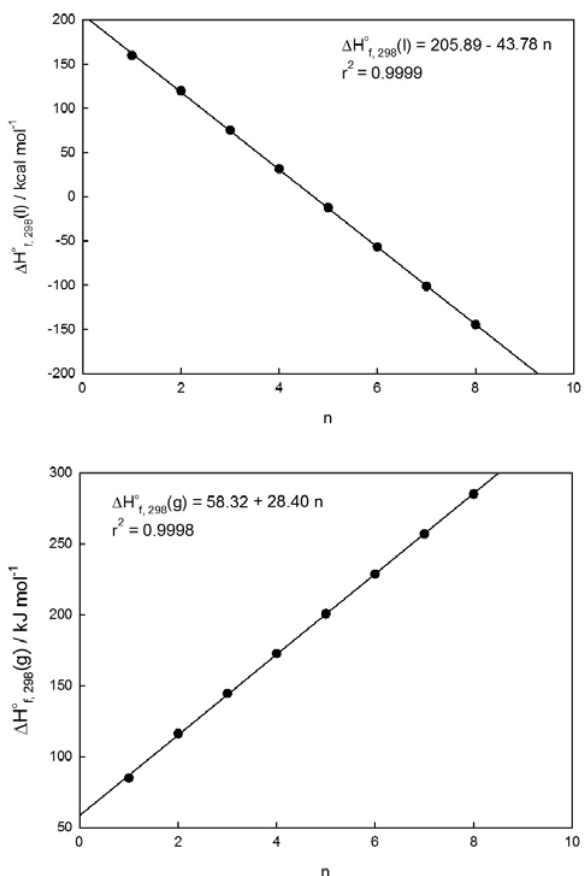
Figure 1. Plot of gas-phase standard molar enthalpies of formation vs. number of carbon atoms in alkyl group for ATs at 298 K, obtai- ned using atomization reaction route at B3LYP/6-31G(d,p) and HF/6-31G(d,p) levels of theory (up and down,